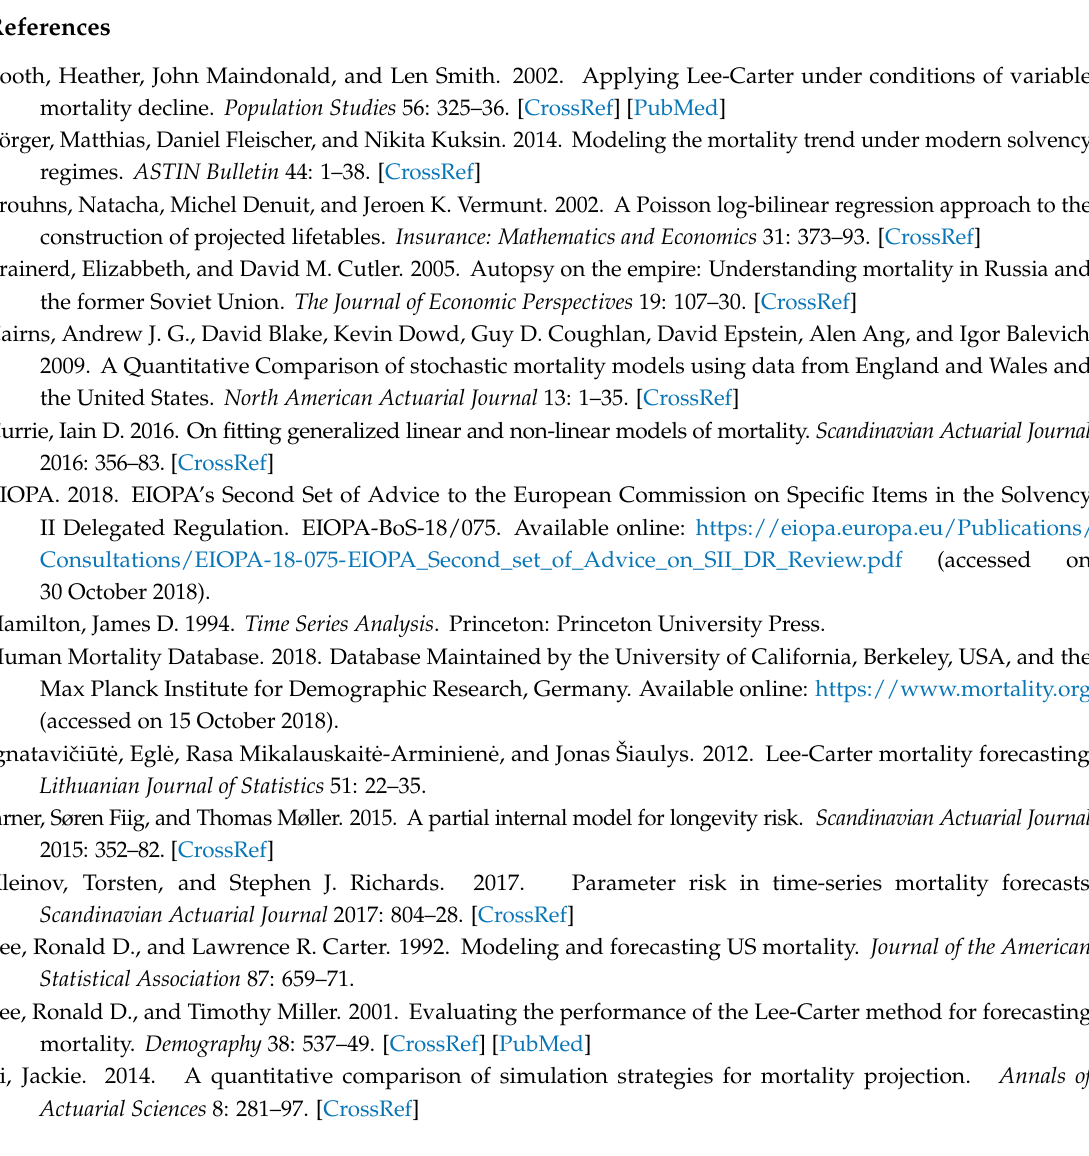
Figure A2. Lee-Carter model parameters κ ( t ) estimated using Singular Value Decomposition (SVD) (before and after second step re-estimation) and Poisson (before and after re-estimation using smoothed β x parameters) methods using data of Lithuania ( a ), Sweden ( b ), Poland ( c ) and the Netherlands ( d